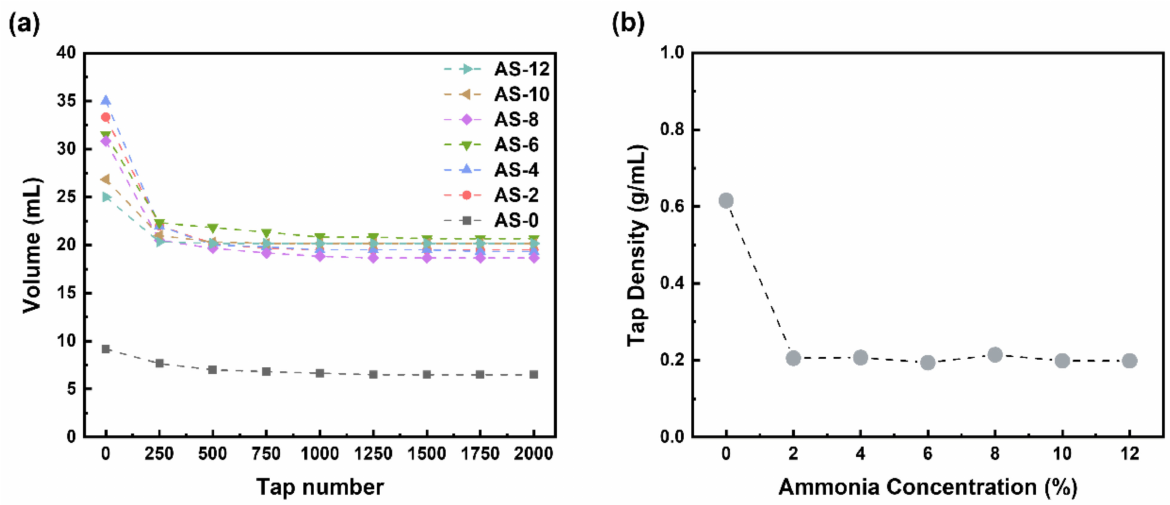
Figure 8. ( a ) tap volume and ( b ) tap density change of synthesized aluminum silicate powder according to ammonia contents.